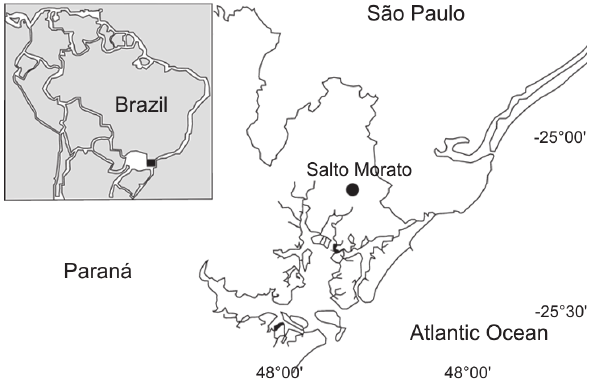
Figure 1. Location of the study area: Reserva Natural Salto Morato, Guaraqueçaba. Source: S TRAUBE & U RBEN -F ILHO (2005). Four surveys were conducted from July 2009 to April 2010, with sampling every three months, covering the four seasons (winter, spring, summer and autumn), in a forest belt, located between 200 and 300 m of altitude. To sample the community of frogs we used the large-plot method sampling (R OCHA et